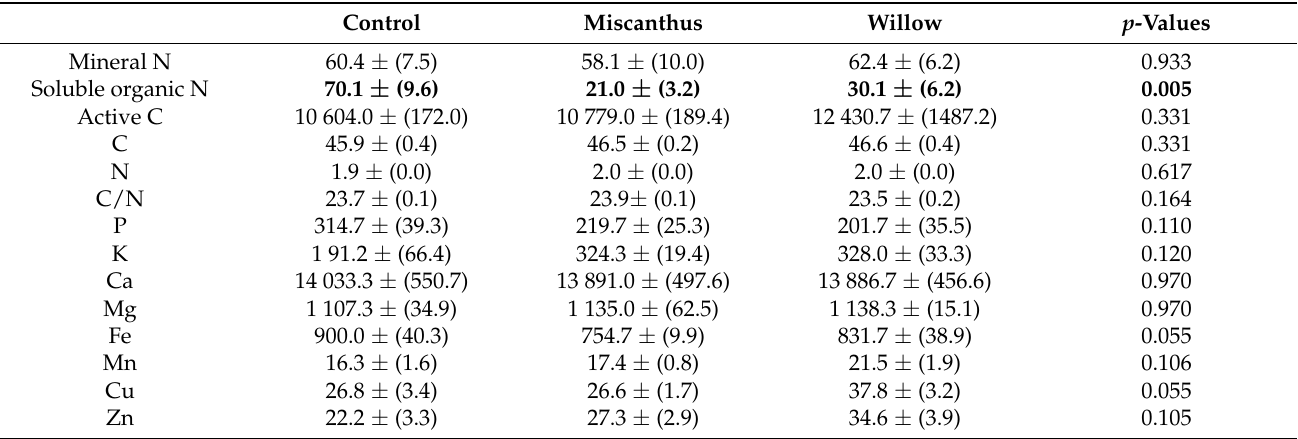
Table 4. Mean ± (se) and p -values (Tukey’s test) for different soil parameters measured in the soil at the end of lettuce growth as a function of amendment.